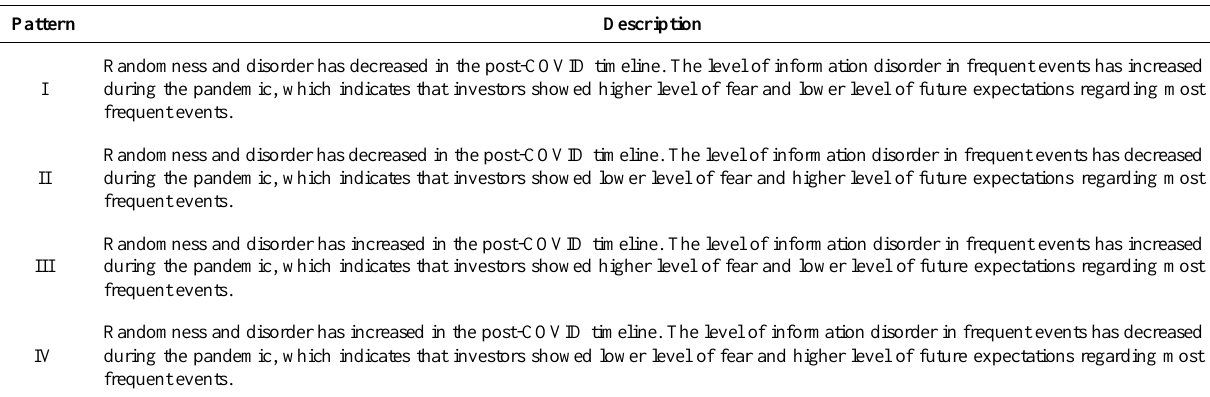
Table 5. Description of different patterns detected in Rényi entropy outputs